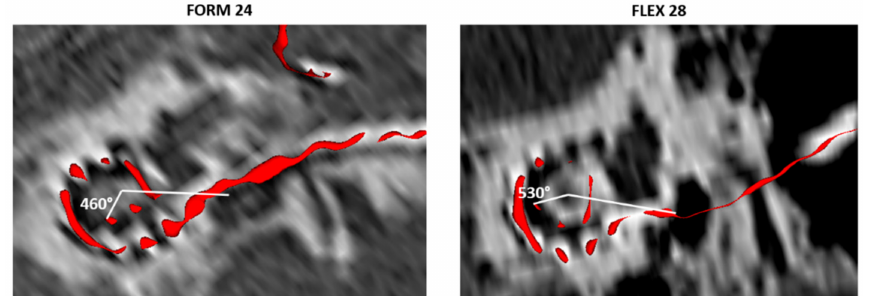
Figure 5. Angular depth of insertion of the FORM 24 electrode array ( left panel ) and FLEX 28 electrode array ( right panel